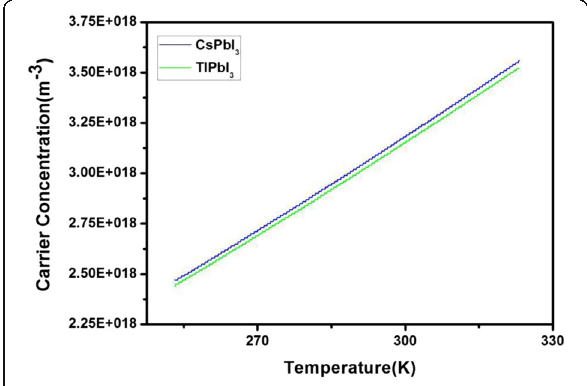
Fig. 5 The relationship between temperature and carrier